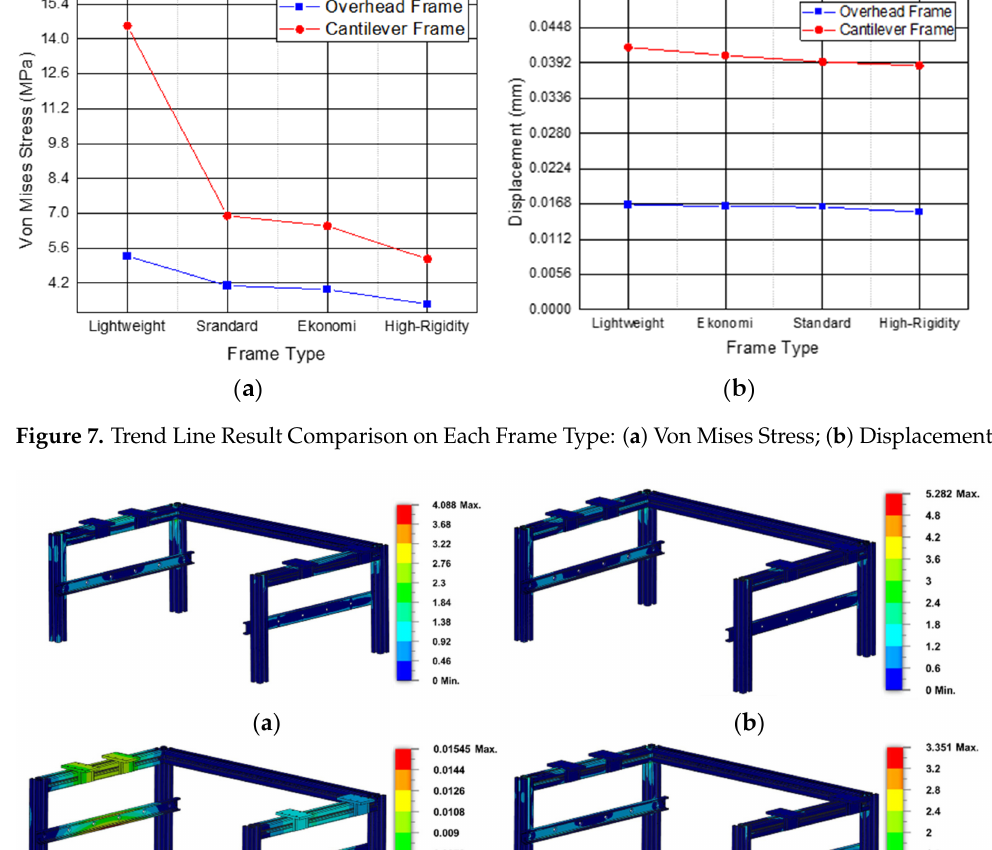
Figure 8. Contour of Von Mises Stress on Overhead Crane: ( a ) Standard Type; ( b ) Lightweight Type; ( c ) Economy Type; ( d ) High-Rigidity Type.